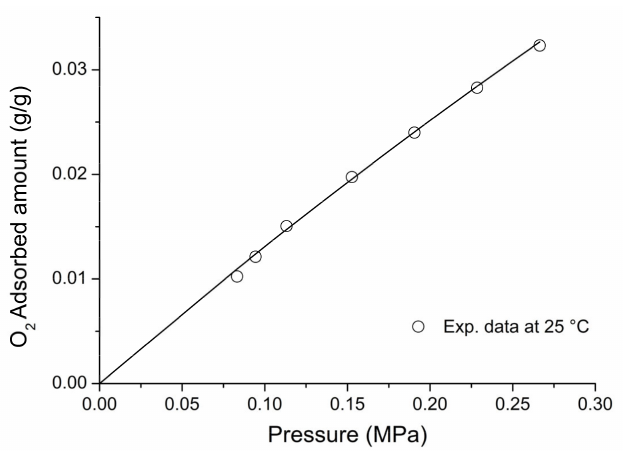
Figure 8. Comparison between experimental O 2 adsorption data in Cu-BTC [48] and simultaneous optimized RALF model fitting (solid lines).